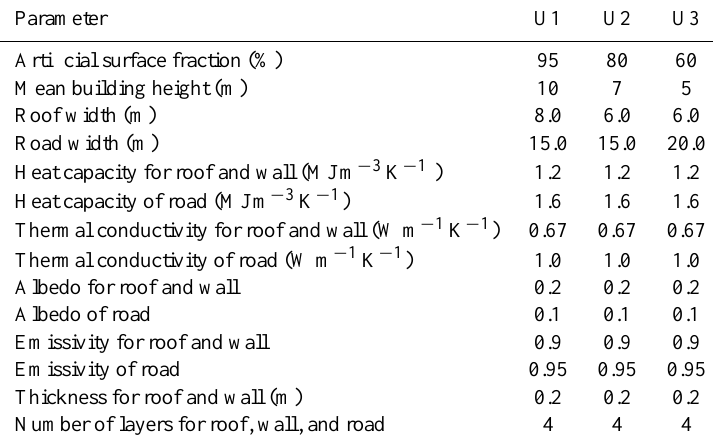
Table 3. Urban morphological, thermal, and radiative parameters used in the UCM simulation. U1, U2, and U3 represent the commer- cial/industrial area, the high-density residential area, and the low-density residential area, respectively. Parameter U1